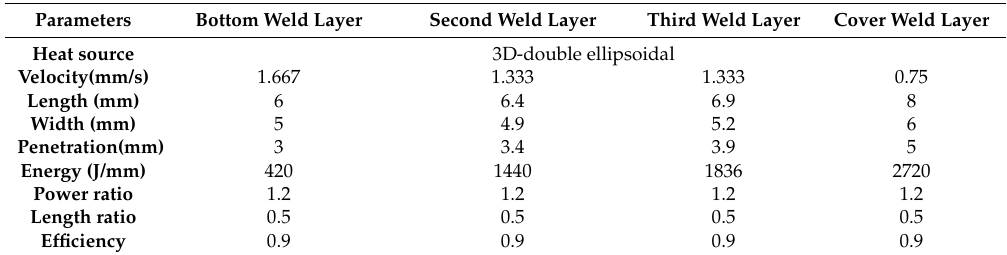
Table 4. The finalized parameters of the heat source model in the simulation. Parameters